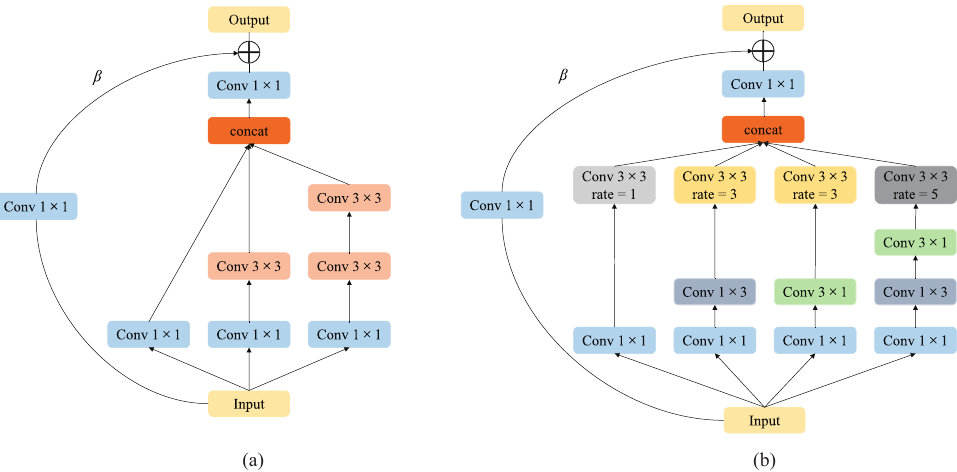
Figure 2. Multi-scale convolution unit. ( a ) is the RIB used in the front layers of the network, ( b ) is the RRFB used in the posterior layers of the